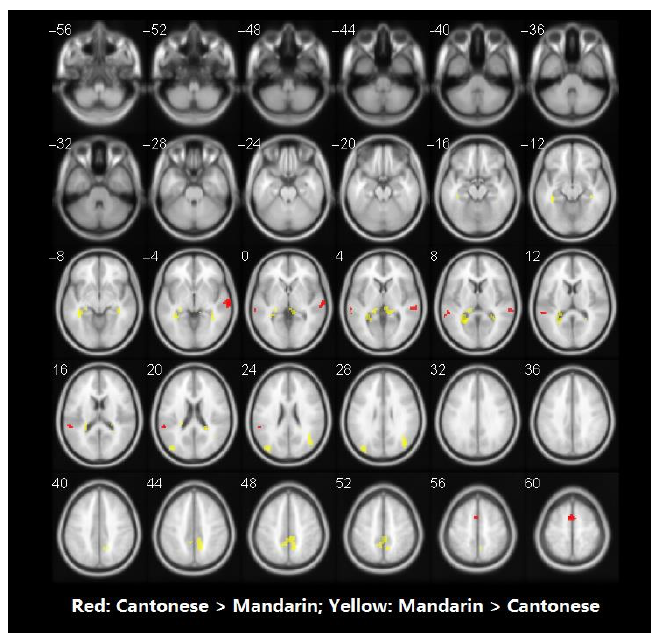
Figure 5. Brain activity for the contrast of rhyming minus control for group comparisons in auditory modality. No significant voxels have been found in the comparison between Cantonese and English. Statistical significance was set as p < 0.001 with voxels ≥ 40.